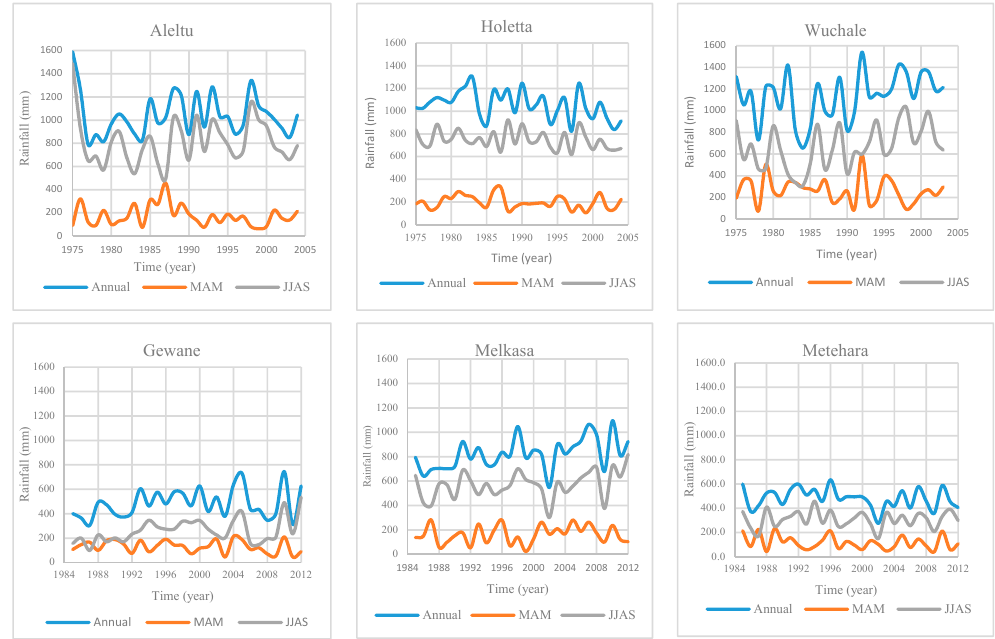
Figure 5. Seasonal temporal variability of rainfall in selected stations in Groups 3 and 4 (MAM and JJAS). Table 1. Summary of descriptive statistics of rainfall in